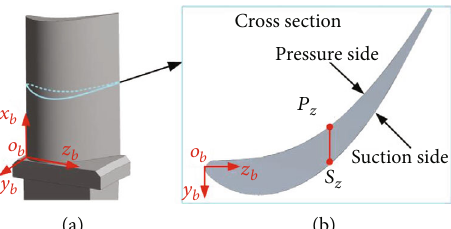
Figure 6: The schematic of crack position. (a) The position of blade cross-section. (b) The blade cross-section.